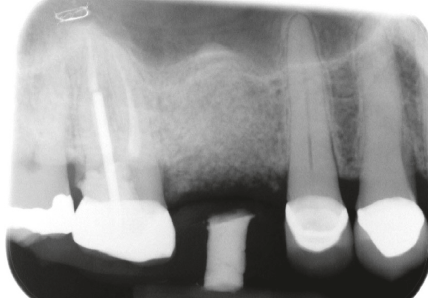
Figure 6: A periapical radiograph 3 months after the extraction and ridge preservation showed no signs of residual pathology.